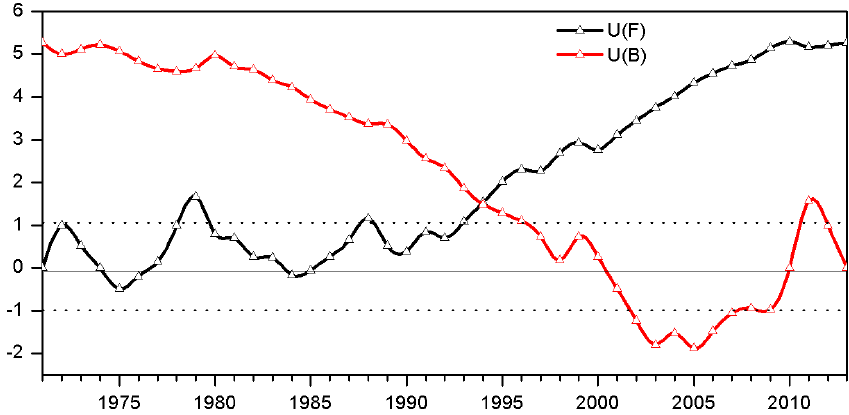
Figure 5. Mann-Kendall analysis for annual mean air temperature over Myanmar in 1971–2013. The forward sequential statistic U(F) is denoted by a solid black line and the backward sequential statistic U(B) is denoted by a solid red line. The dotted black lines above and below represent significance at the 95% confidence level, and the solid black line marks 0.